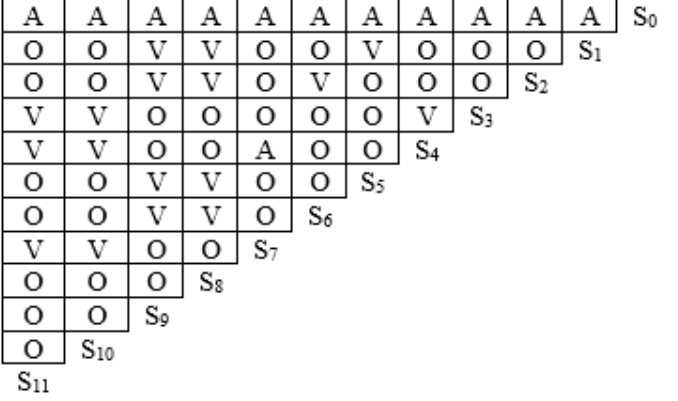
Figure 3. Logical relationship diagram of the influencing factors.